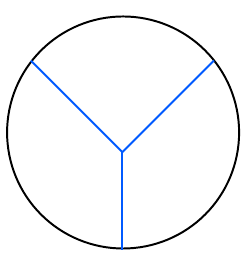
Figure 2. A cubic coupling of the bulk (cid:12)elds (cid:30) n gives rise to the tree level interaction of the bulk (cid:12)elds shown in this Feynman-Witten diagram. Extrapolating the bulk points to the boundary gives, via the AdS/CFT dictionary, the CFT three-point function of the composites O n